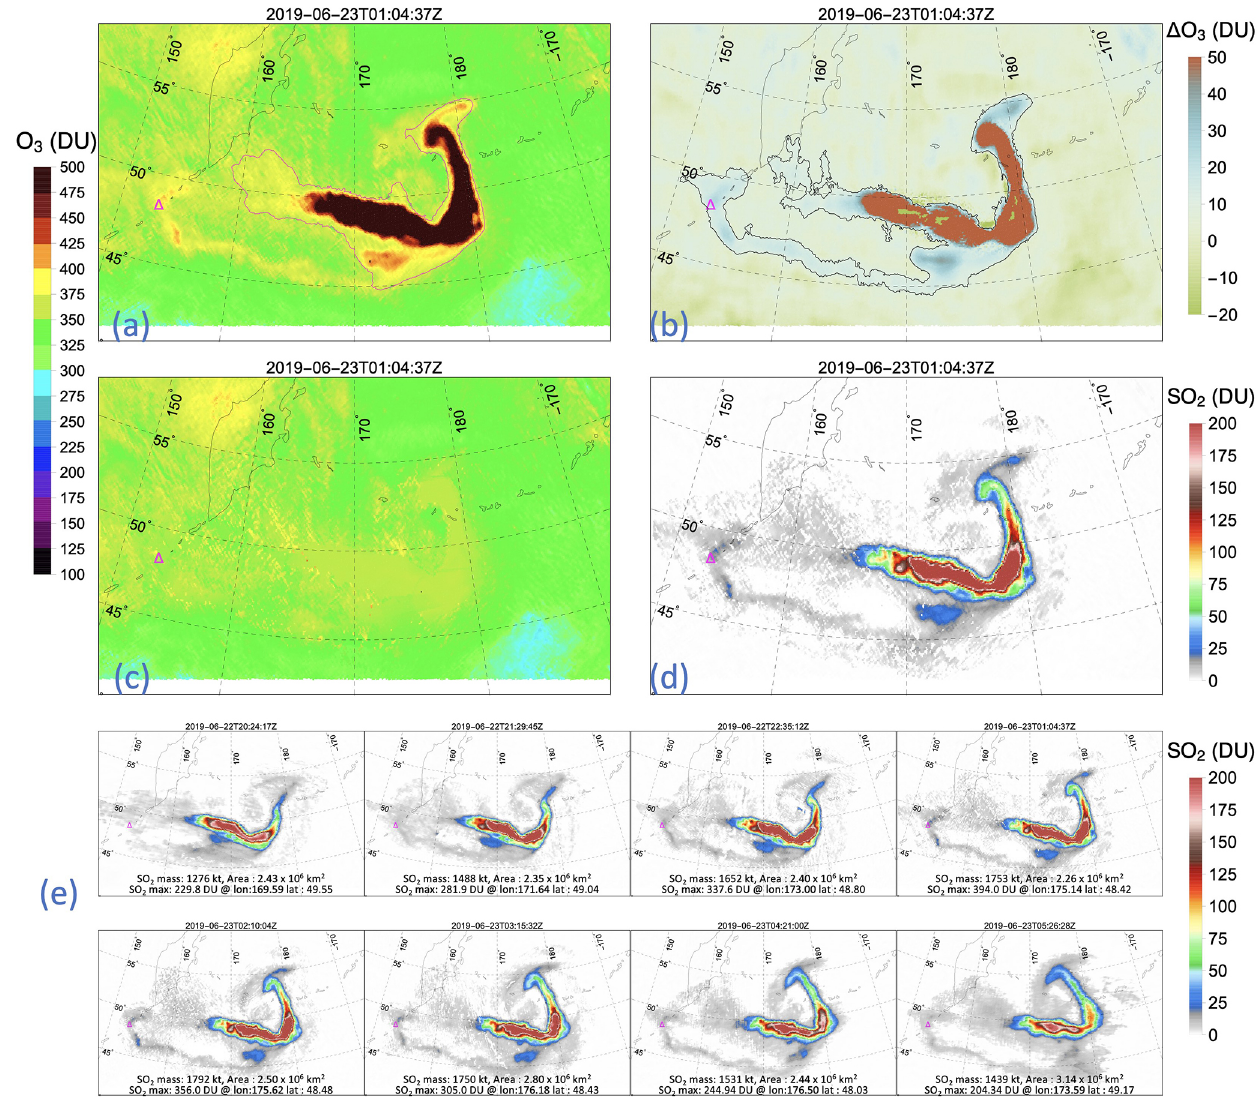
Figure 16. EPIC observation of the volcanic plume on 23 June 2019 from the previous day’s eruption of Raikoke volcano (represented by (cid:49) in each panel) in the central Kuril Islands of Russia. (a) B1 O 3 column ( (cid:127) 1 ) from EPIC total ozone retrieval and the elevated O 3 contour. (b) B1 and B2 O 3 column difference ( (cid:49)(cid:127) = (cid:127) 1 − (cid:127) 2 ) and elevated (cid:49)(cid:127) contour. (c) Vertical O 3 column from EPIC total SO 2 retrieval (see Algorithm 2). (d) Vertical SO 2 column from EPIC total SO 2 retrieval. (e) SO 2 vertical column retrieved from a series of eight